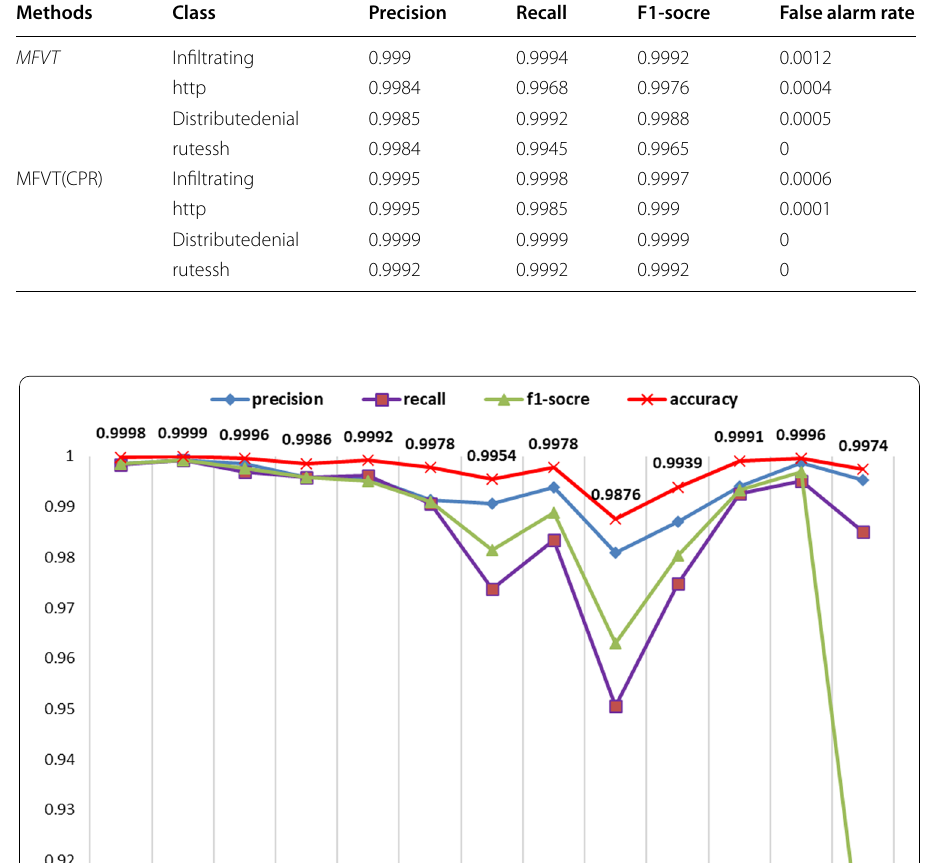
Table 4 Performance of MFVT model and CPR algorithm in each category in IDS 2012 data Methods